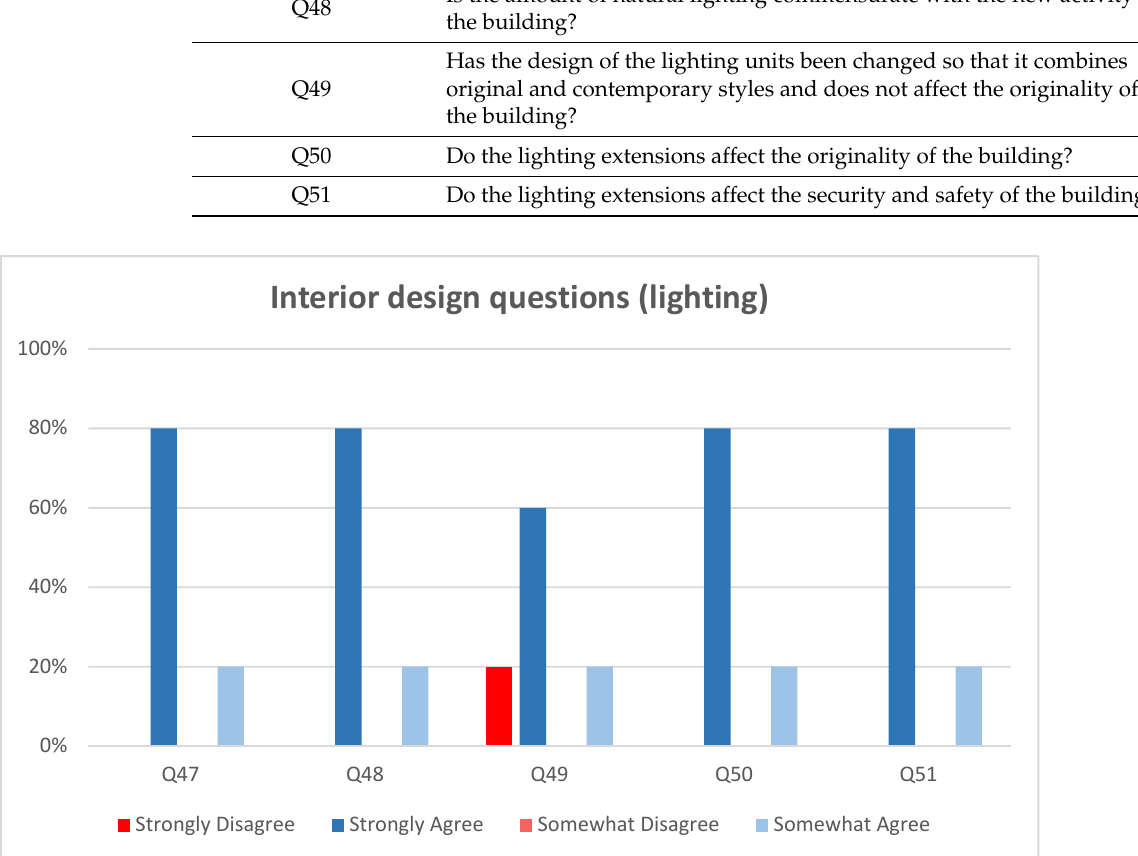
Table 10. Interior design questions